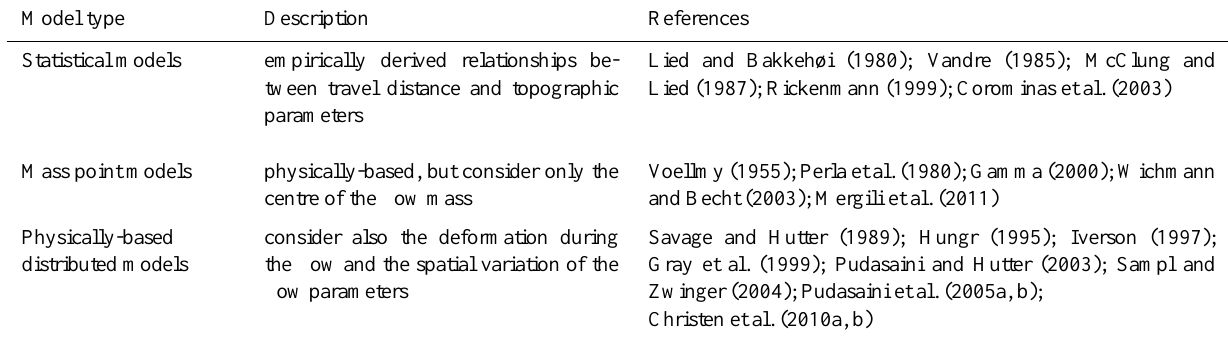
Table 1. Types of models for granular flows, partly based on Pudasaini and Hutter